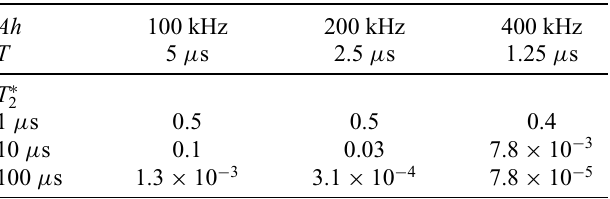
TABLE II. The electron Z -error probabilities induced by Over- values and e-n-CPhase gate times hauser rotations for various T ∗ 2 (with corresponding hyperfine strengths in hertz, Ah , where h is Planck’s constant) computed directly from Eq.